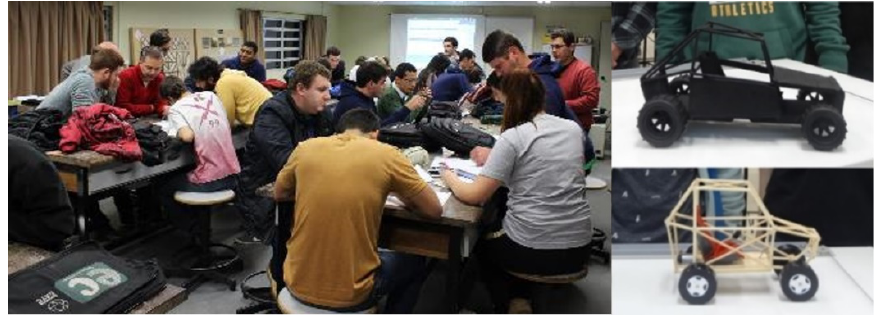
Fig. 5. Left side: Active Learning classes (Level 1); 2nd semester 2016, SATC College, Me- chanical Engineering Course. Subject: Technical Drawing. Right side: manufacture of prototypes using the basic concepts of the subject (design) and rapid prototyping re- sources (laser cut machine and 3D